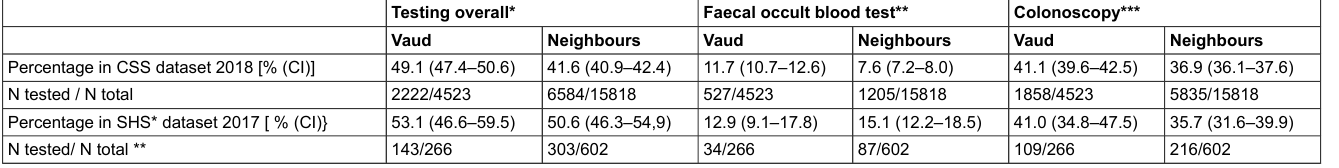
* OR of being tested for faecal occult blood test or colonoscopy versus no test for each calendar year. Results from multivariate adjusted logistic regression model adjusted for sex, age, pharmacy-based cost group categories, managed care model, Year considered, Canton Vaud vs the other neighbouring cantons. Interaction term added testing the interaction between period before the organized screening program (years 2011-2014 vs 2015–2018) and canton Vaud vs the other cantons. ** OR of being tested for faecal occult blood test only (or faecal occult blood test and colonoscopy) or colonoscopy only versus no test for each calendar year. Results from multivariate adjusted multinomial model adjusted for sex, age, pharmacy-based cost group categories, managed care model, Year considered, Canton Vaud vs the other neighbouring cantons. Interaction term added testing the interaction between period before the organized screening program (years 2011–2014 vs 2015–2018) and canton Vaud vs the other cantons.